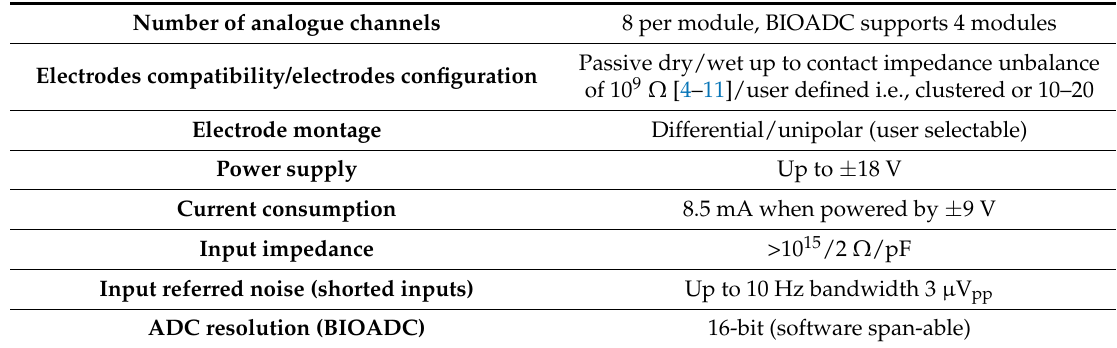
Table 1. Summary of electrical characteristics.